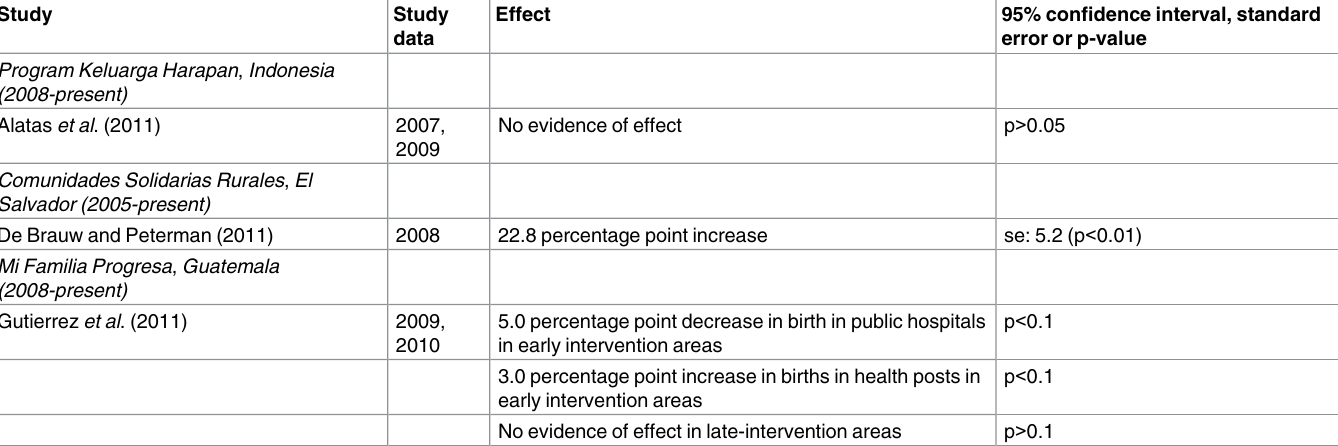
Table 3. Effect of conditional cash transferson births attended at a healthcare facility.